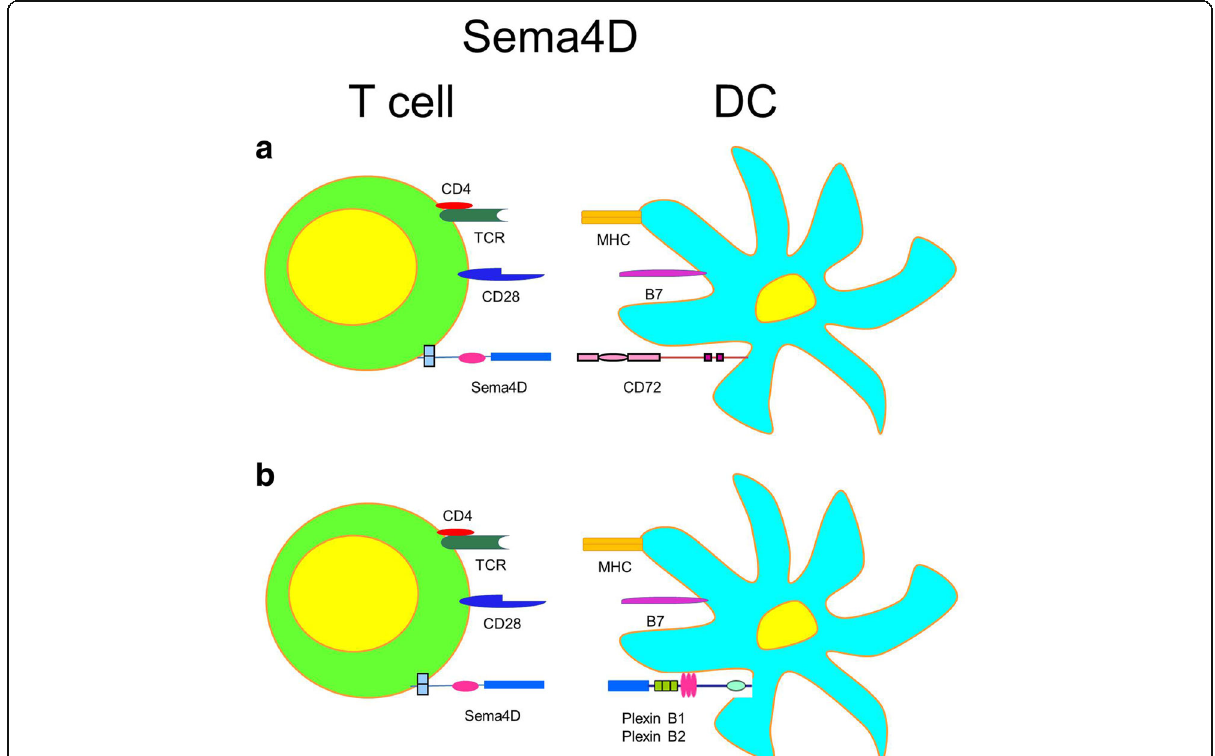
Fig. 4 Distinct receptor-dependent effects of T cell-expressed Sema4D on DC functions. a Sema4D costimulates T cells. Sema4D serves as an indirect costimulatory molecule for T cell activation. Sema4D on T cells stimulates DC to accelerate their activation and maturation. Stimulated DC, in their turn, enhance T cell activation. The main receptor for such Sema4D action is believed to be CD72. b Sema4D costimulates DC. T cell-expressing and soluble Sema4D ligation of DC-expressing Plexin B1 and B2 receptors stimulates DC proinflammatory cytokine production and